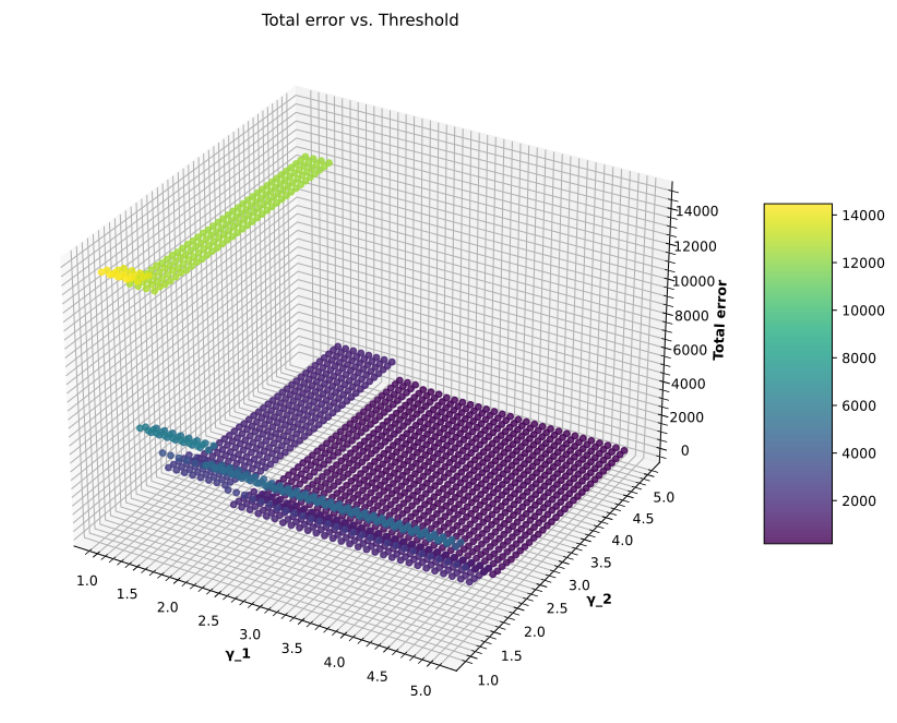
Figure 9. Total error vs.